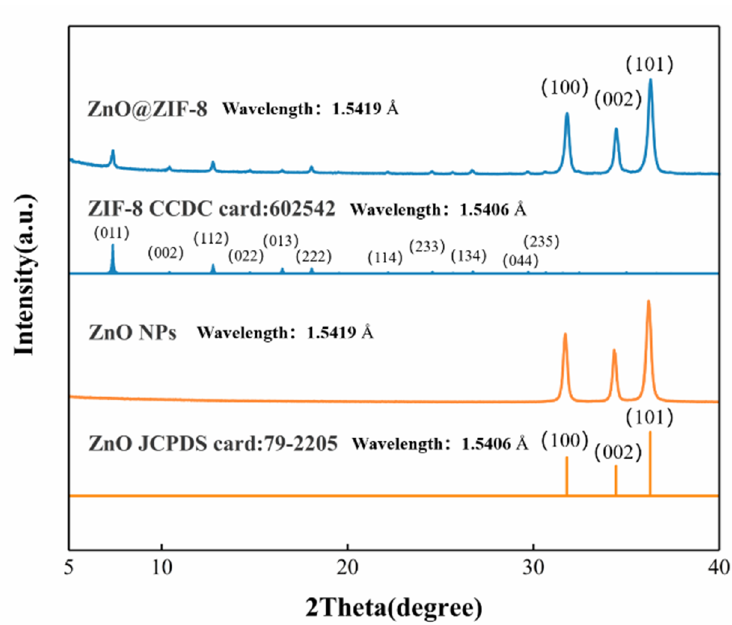
Figure 3. XRD patterns of the ZnO NPs and the simulated XRD patterns of ZnO@ZIF-8: The PDF standard card of ZnO and ZIF-8 are given under the respective measured patterns.